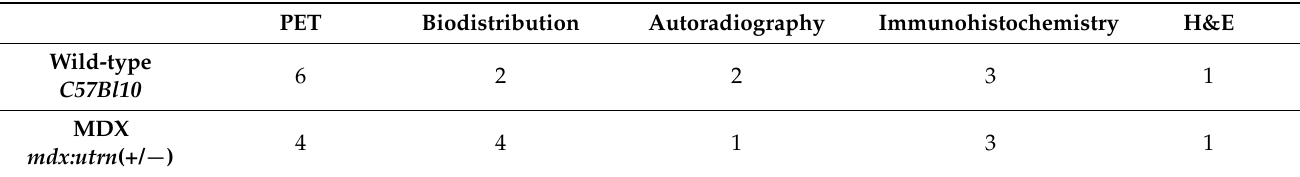
Table A1. Sample size for the number of unique wild-type and MDX mice successfully completed for each protocol